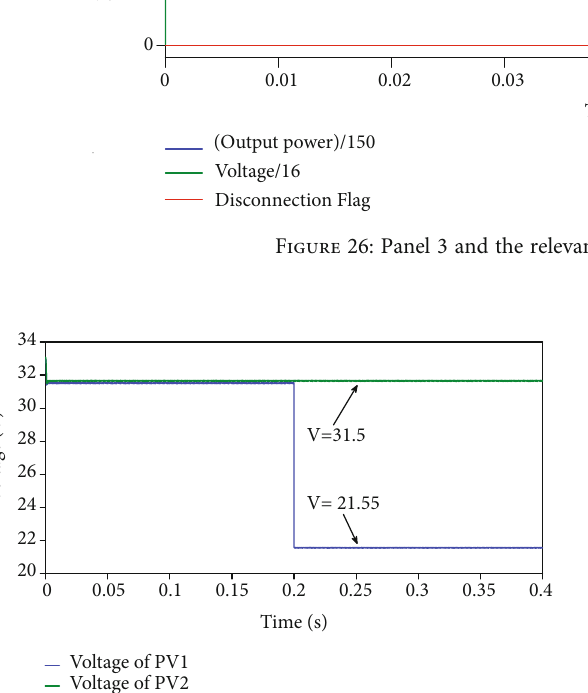
Figure 27: The output voltage of PV1 and PV2, while one of the PV1 panels ’ is